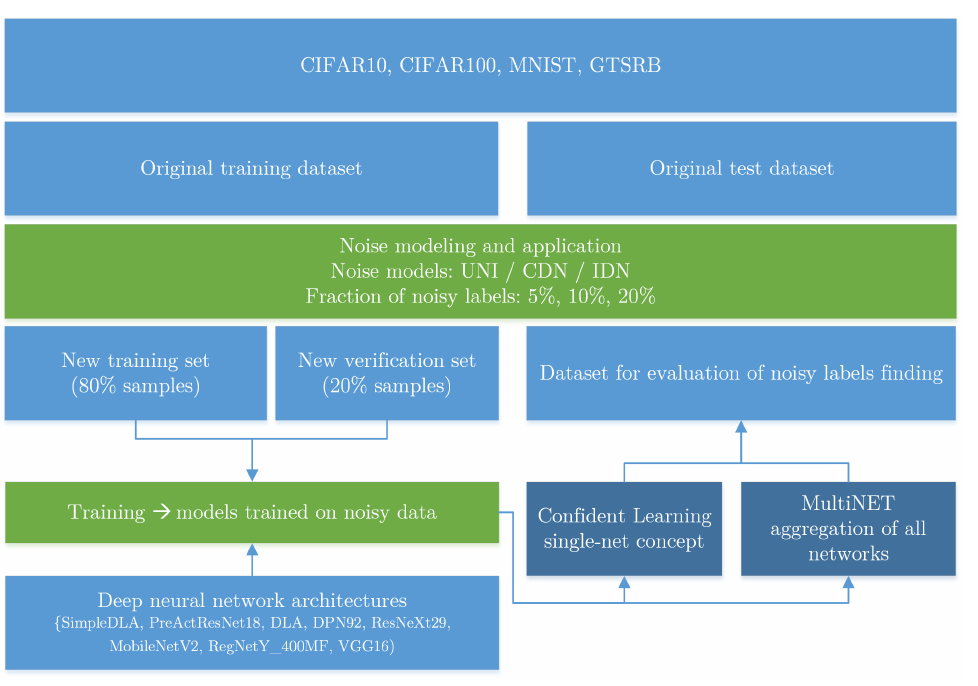
Figure 1. Experimental schema. The original training dataset is divided into new DNN training and verification sets. The original test dataset is used to evaluate the ability of the algorithms to detect noisy labels.